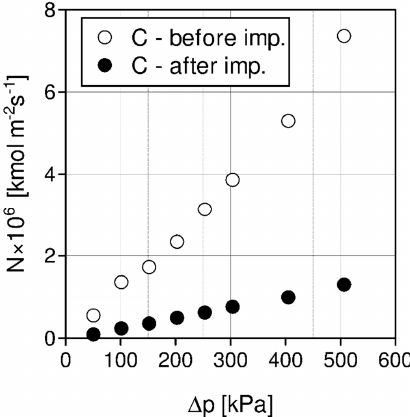
Figure 8. Carbon dioxide molar fluxes for membrane C (PDMS) before and after impregnation with [Emin][Ac], temperature 20 °C. The measured ideal selectivities are much higher after impregnation of the mem- brane C (PDMS) with ionic liquid [Emim][Ac], Figure 9.